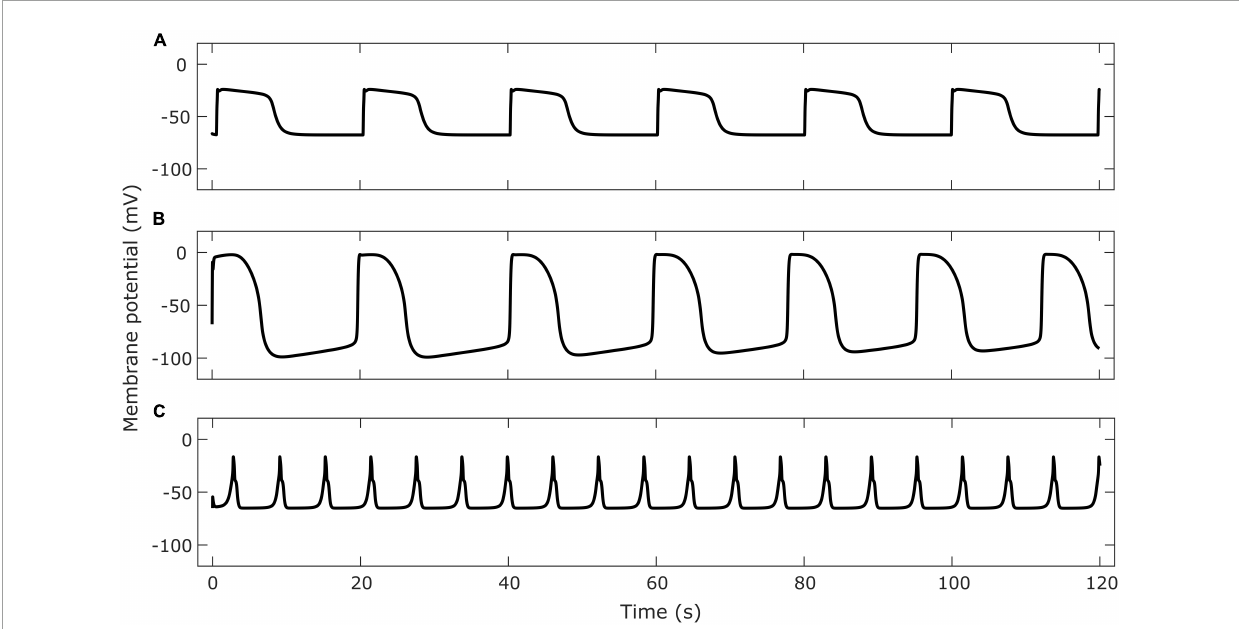
FIGURE1 Examples of membrane potential simulated by cell models of gastrointestinal ICC. Cell model implementations were retrieved from the Physiome Model Repository. Panel (A) shows the membrane potential in a single gastric ICC-MY cell using the Corrias and Buist (2008) model. Panel (B) shows the membrane potential of a single small intestine ICC-MY using the Youm et al. (2006) model. Panel (C) shows the membrane potential of a single jejunal ICC using the Lees-Green et al. (2014) model.